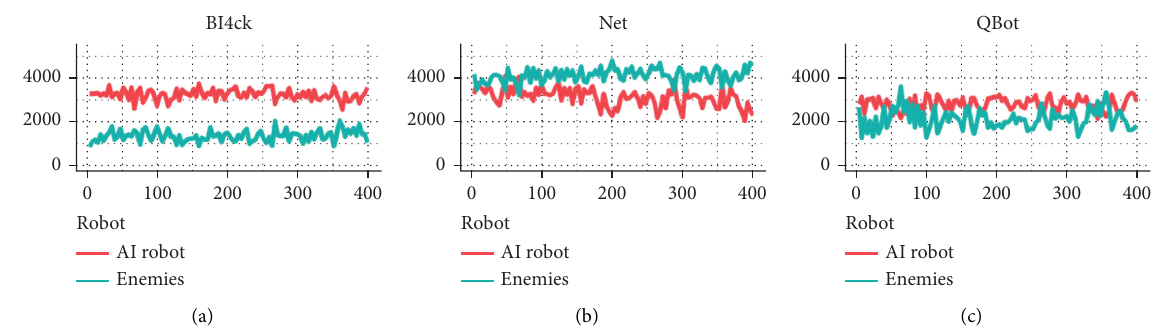
Figure 10: Percentage of actions selected in the 1 st , 2 nd , 3 rd , and 4 th quarters of the training phase (against community robots).